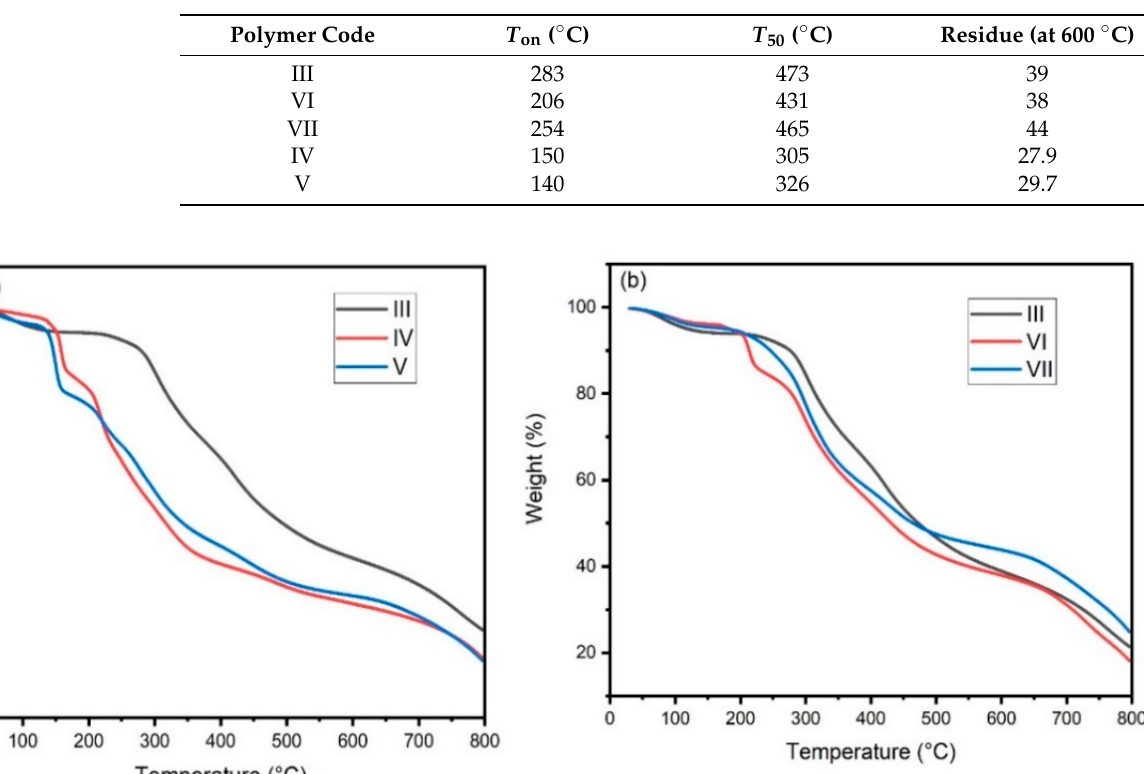
Table 2. Thermogravimetric parameters polymers (III–VII).